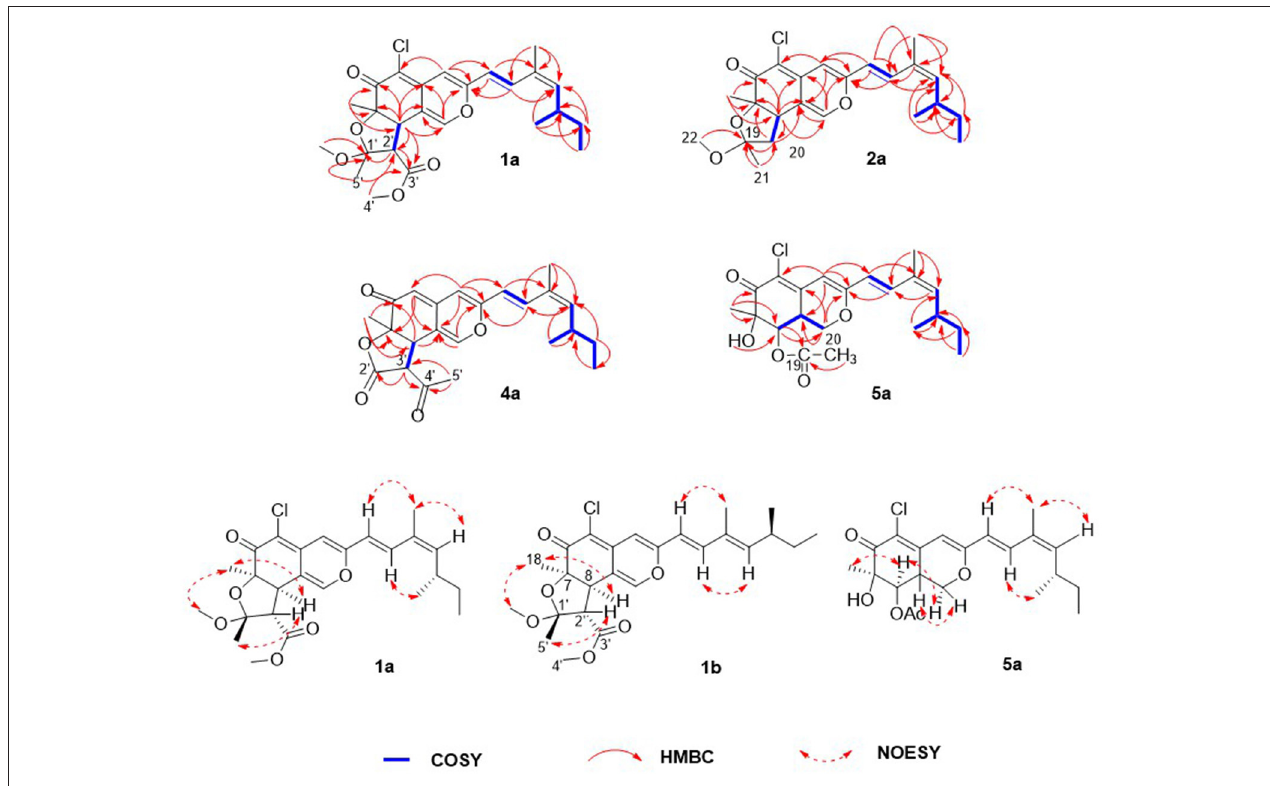
FIGURE 3 | Experimental electronic circular dichroism (ECD) spectrum of compound 1.